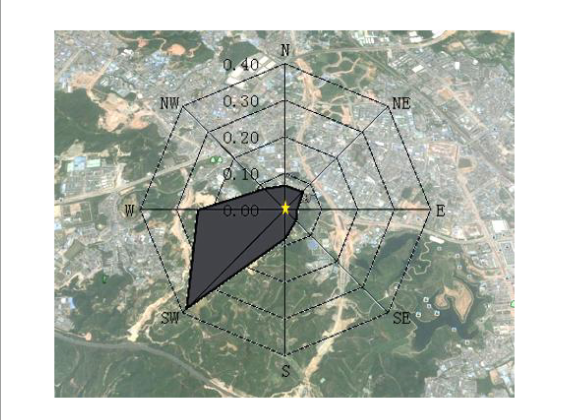
FIGURE1 The dominant wind direction frequency map at the site of the waste incineration plant.